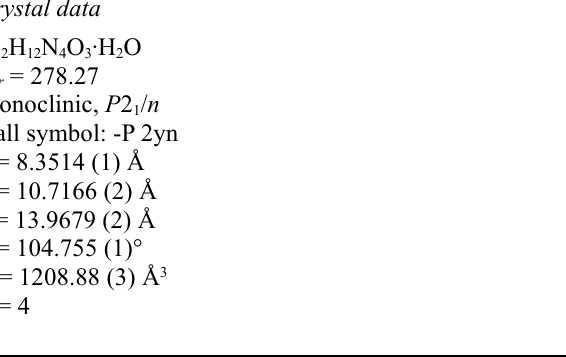
A view of the molecule with the atom numbering scheme. Displacement ellipsoids are drawn at the 50% probability level. 3-(2-Amino-1-methyl-4-oxo-4,5-dihydro-1 H -imidazol-5-yl)-3- hydroxyindolin-2-one